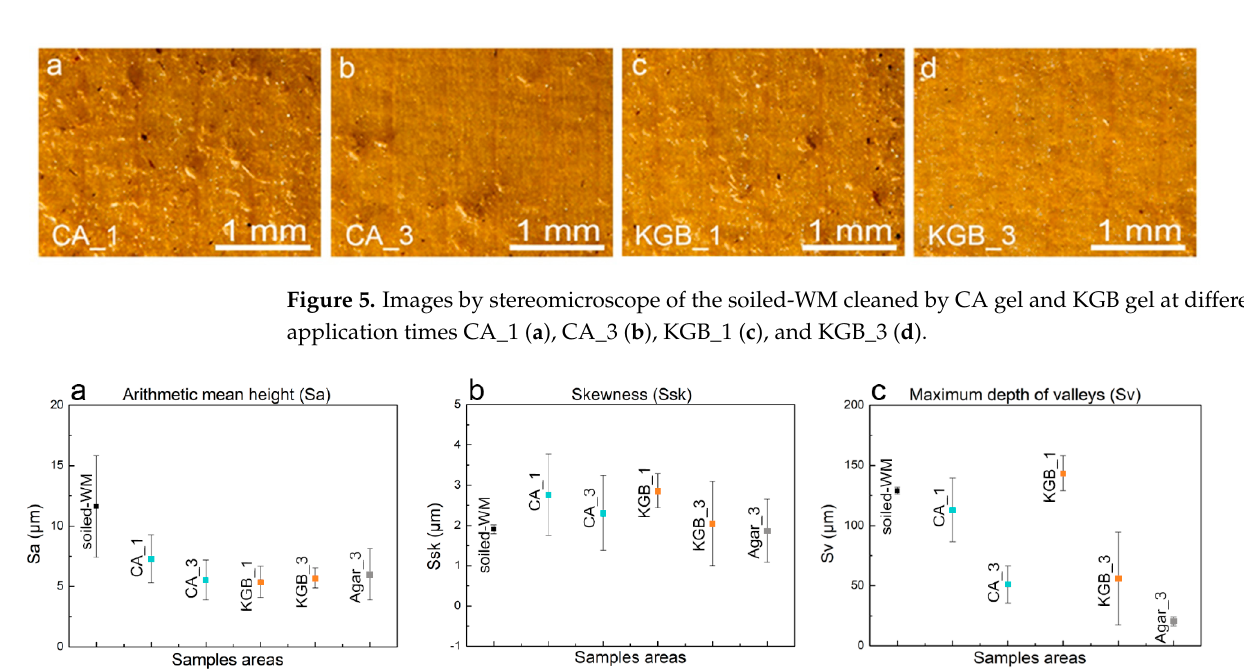
Figure 4. 3D heat maps of soiled-WM ( a ) cleaned by CA_3 ( b ) and KGB_3 ( c ). The colour range represents the different heights (in microns) of the details present on the sample surface.